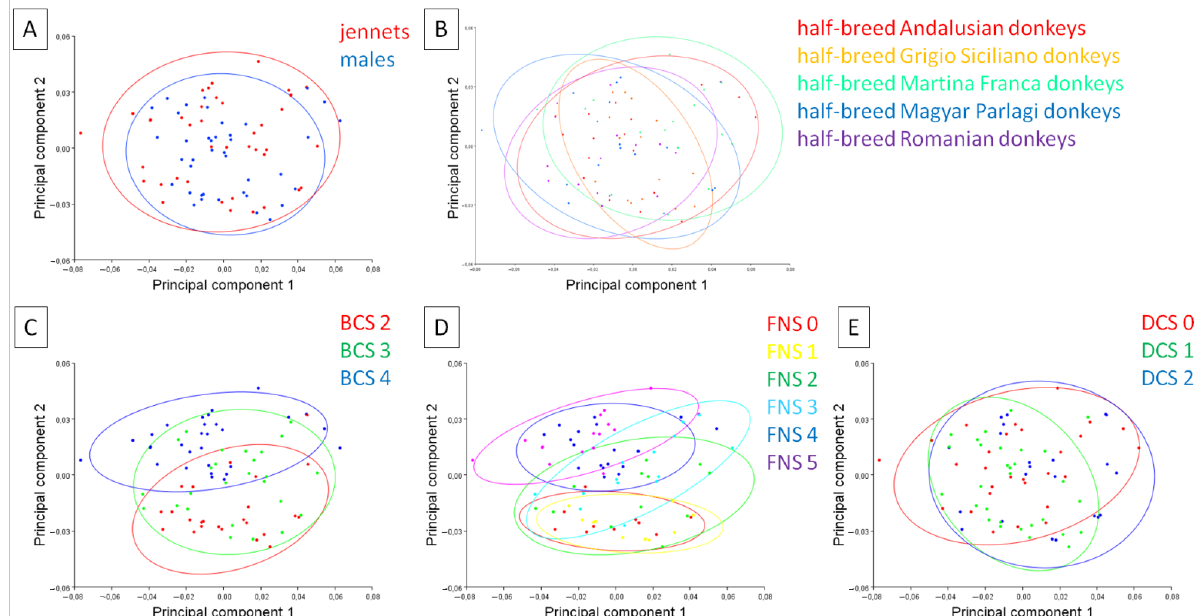
Figure 5. A scatter plot of the principal component scores of the donkeys. The color for each category was determined based on the classifier variables: ( A ) sex (jennets; males); ( B ) breed (half-breed Andalusian donkeys, half-breed Grigio Siciliano donkeys, half-breed Martina Franca donkeys, half-breed Magyar Parlagi donkeys, and half-breed Romanian donkeys); ( C ) body condition score (BCS 2, BCS 3, and BCS 4); ( D ) fatty neck score (FNS 0, FNS 1, FNS 2, FNS 3, FNS 4, and FNS 5); and ( E ) dental condition score (DCS 0, DCS 1, and DCS 2). The confidence ellipses were drawn using a 0.9 probability and a classifier as a criterion for grouping the observations.